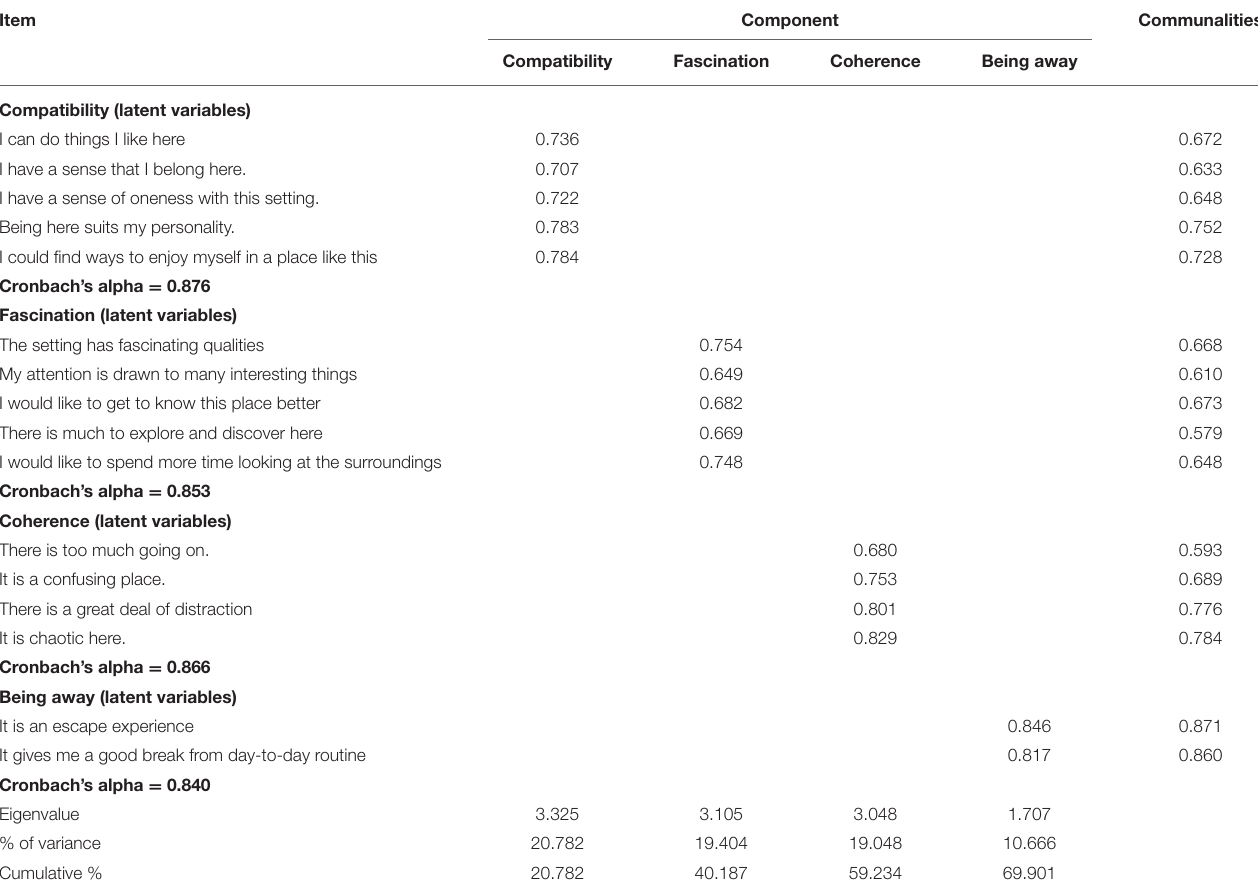
TABLE 5 | Corrected correlations between PRS items and PRS. Item